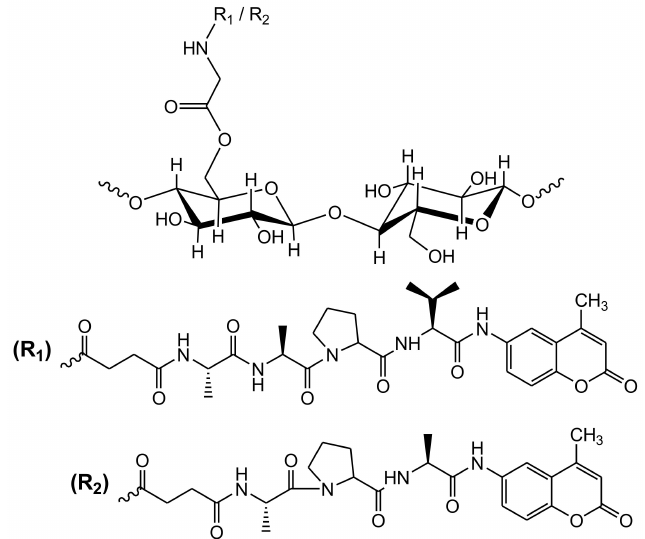
Figure4. Structureofcottoncellulosenanocrystals-[O-C(O)Gly-NHC(O)]succinyl-Ala-Ala-Pro-Val-AMC (R 1 ; tetrapeptide derivative) and cotton cellulose nanocrystals-[O-C(O)Gly-NHC(O)]succinyl-Ala-Pro- Ala-AMC (R 2 ; tripeptide derivative).